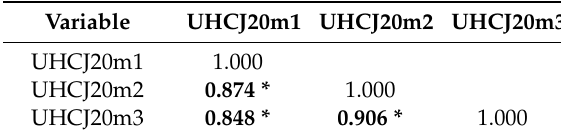
Table 3. Correlation matrix of the repeated measurements in motor test, UHCJ20m.